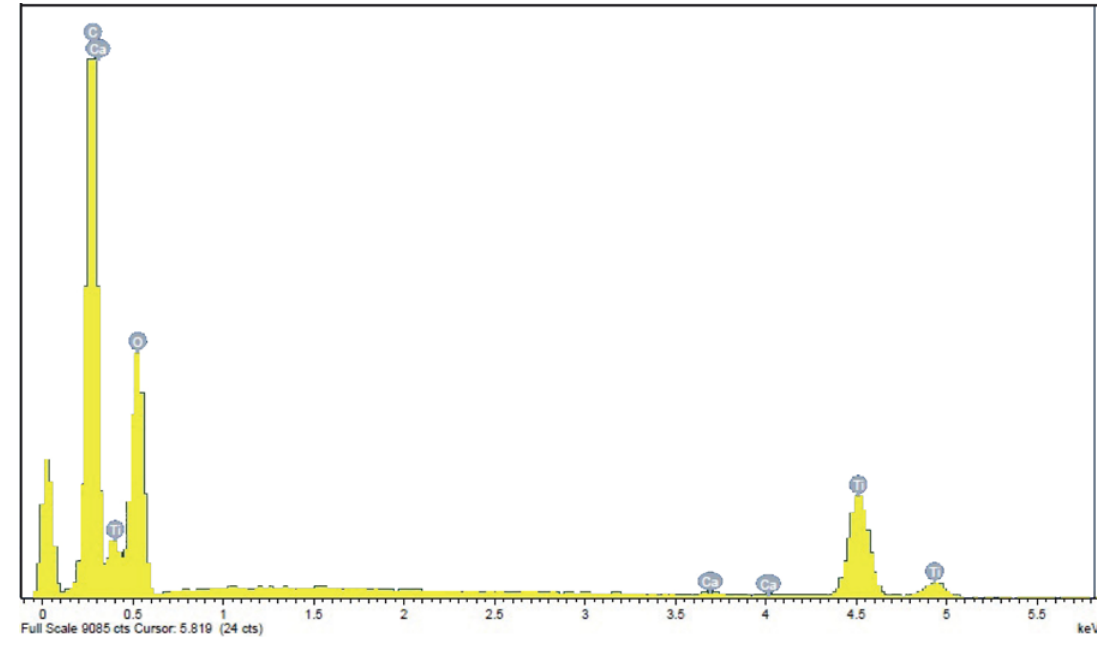
Figure 3. EDX analysis spectrum of the white spot in TiO